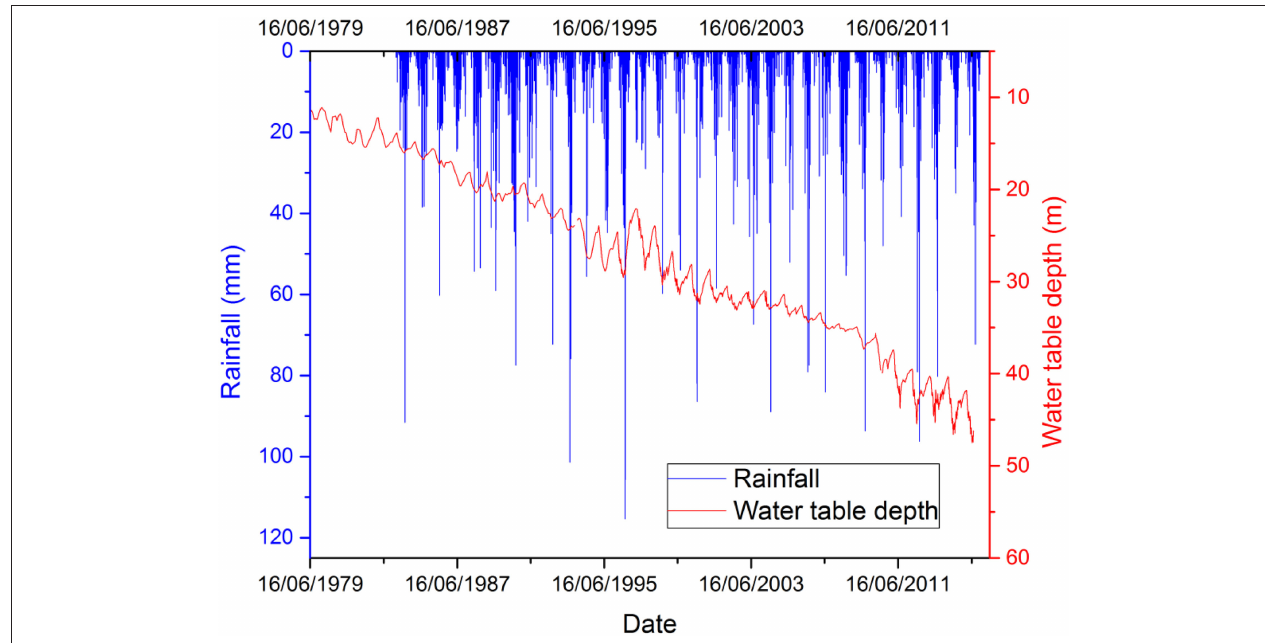
FIGURE 2 | Ground water dynamic changes 1974–2016 at Luancheng Agro-Ecosystem Experimental Station